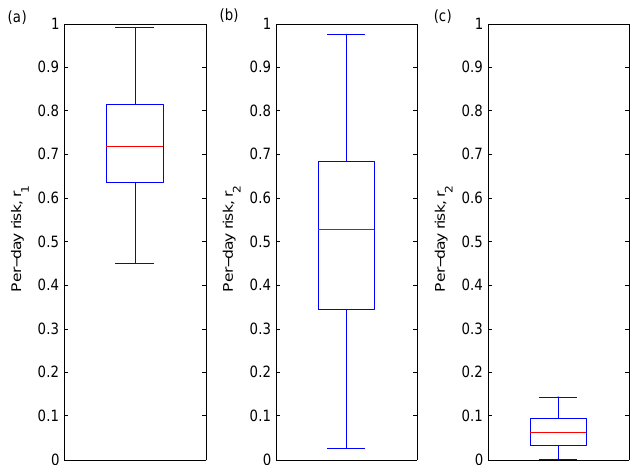
Figure 5. Boxplots of 1000 sampled values using the LHS ranges from Table 1, except with q 7 varying and other q i values set to zero. The horizontal red line indicates the median value. We present the daily risk of COVID-19 under three scenarios: ( a ) before the vaccine; ( b ) after the vaccine but with imperfect vaccine uptake (0.25 < q 7 < 1); and ( c ) after the vaccine and with perfect vaccine uptake ( q 7 =